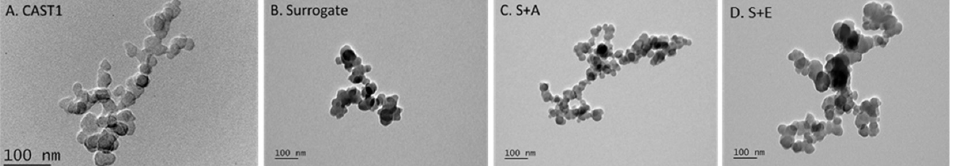
Figure 1. Transmission electron microscopy images of particles from: ( A ) CAST1; ( B ) gasoline Sur- rogate; ( C ) B2G Surrogate anisole (S+10A); and ( D ) Surrogate ethanol (S+10E). Surrogate; ( C ) B2G Surrogate anisole (S+10A); and ( D ) Surrogate ethanol